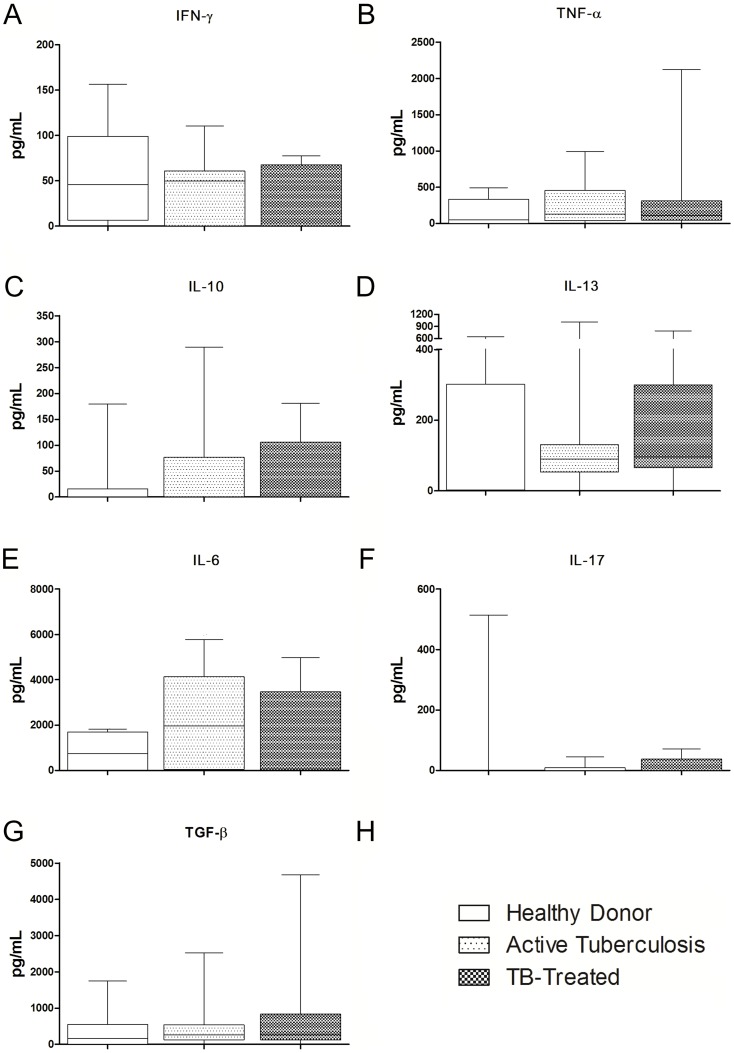
Cytokine plasma levels in active and clinically cured tuberculosis.Plasma levels of TNF-α, IFN-γ, IL-10, IL-4, IL-13, IL-6, IL-17, TGF-β and IL-22 in Healthy Donors, patients with active tuberculosis and clinically cured patients (A–G). Horizontal lines represent the median, bars represent 25–75 percentiles, and vertical lines represent 10–90 percentiles. *p<0.0167: Kruskal-Wallis test (followed by post-hoc Bonferroni/Dunn test for multiple comparisons).